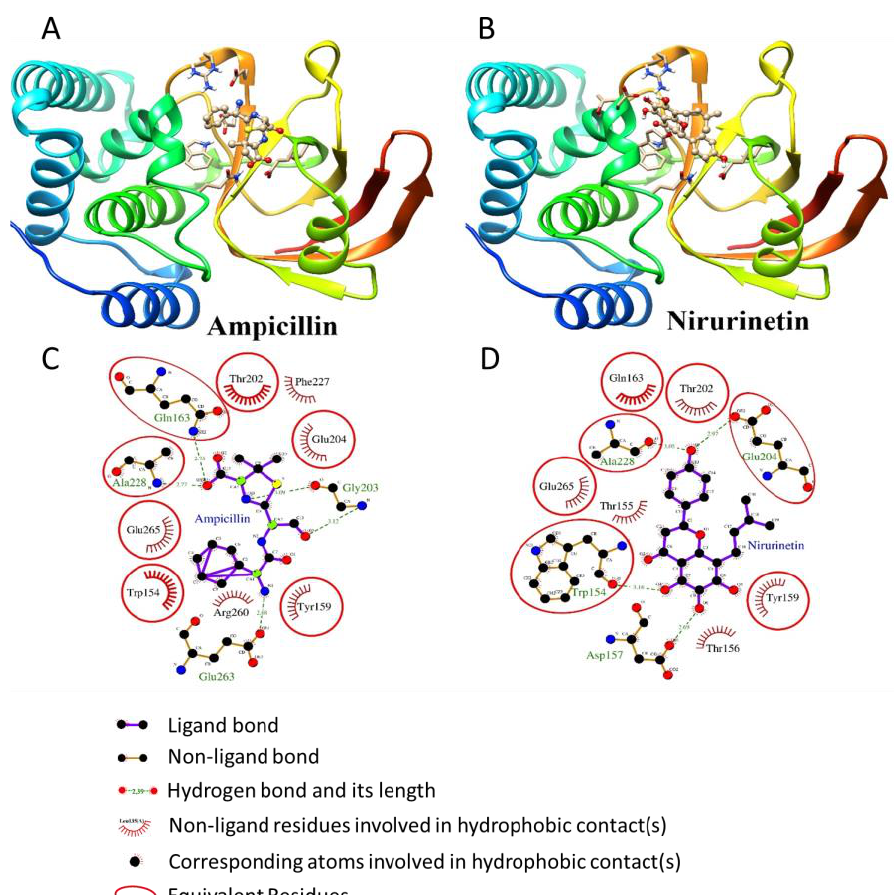
Figure 5. Molecular docking analysis of ampicillin and nirurinetin with type-III Effector XopAI Protein. ( A , B ) The binding pattern of ( A ) ampicillin and ( B ) nirurinetin with Arg-peptide-binding cleft (central cleft) of type III effector XopAI. Ligands are represented in the ball & stick model and type III effector XopAI in a ribbon structure. Nirurinetin exhibited a similar binding pattern to that shown by the ampicillin molecule. ( C , D ) Assessment of H-bonding and hydrophobic interaction pattern of ( C ) ampicillin and ( D ) nirurinetin with Arg peptide-binding cleft (central cleft) of type III effector